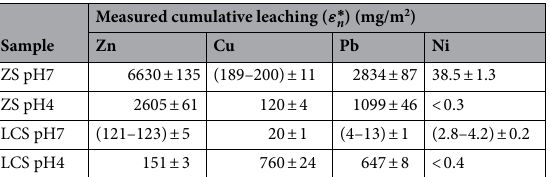
Table 4. Measured cumulative leaching ( ε ∗ n ) of Zn, Cu, Pb, Ni obtained in the tank test (mean ± u c ( ε ∗ n ), n = 8).